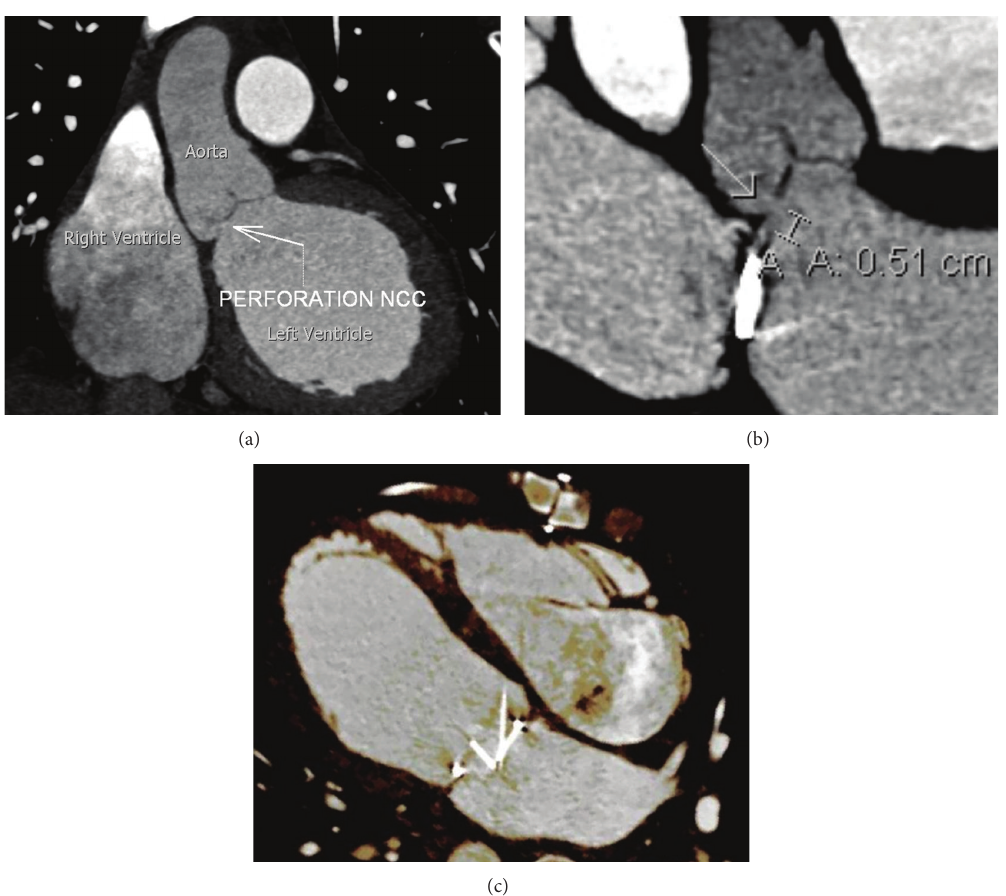
Figure 3: Cardiac gated computed tomography. (a) Large and (b) magnified oblique reformatted images of the left ventricular outflow tract and aortic valve demonstrate a clearly visible 5mm defect in the non-coronary cusp of the aortic valve. (c) Four-chamber orientation shows the asymmetric movement of the bileaflet mechanical mitral valve due to the regurgitant jet originating from the aortic valve defect. Supplementary CINE file online shows 3D rendering of paradoxical mitral valve motion (see supplementary CINE